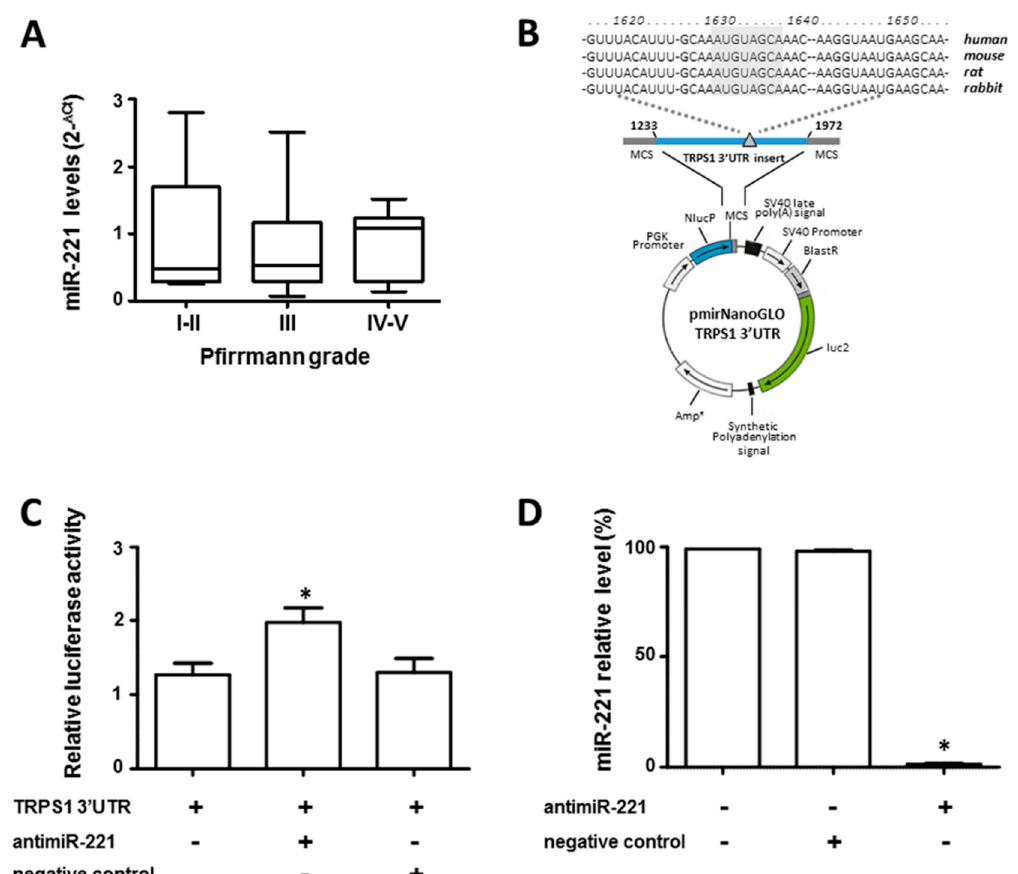
Figure 4. miR-221 directly targets TRPS1. The endogenous expression level of miR-221 was evaluated by qRT-PCR in the cells from IVD with a di ff erent Pfirrmann grade of degeneration ( A ). The relative miR-221 expression levels were reported by using 2 −(cid:52) Ct method (U6 snRNA was employed for normalization; all reactions were performed in triplicate, n = 30 (Pfirrmann I-II group, n = 8; Pfirrmann III group, n = 9 and Pfirrmann IV-V group, n = 13). Validation of miR-221 target site in the TRPS1 3 (cid:48) -UTR by reporter gene assay in IVD cells ( B ). Schematic representation of the luciferase construct utilized in this study is reported; partial sequences of the TRPS1 mRNA 3 (cid:48) -UTR harboring the predicted miRNA target site (gray triangle) was inserted in the indicated position. In the upper part of the panel the position of the predicted highly conserved miRNA target site is indicated. IVD cells were transfected for 48 h with a combination of reporter constructs (100 ng) along with antimiR-221 or negative control ( C ). Afterwards, the Nano Luc luciferase reporter gene ( NlucP ) and Firefly luciferase control reporter activities (luc2) were measured using a Nano-Glo Dual-Luciferase assay and represented as mean ± SD ( n = 6). The e ffi ciency of miR-221 silencing after antimiR-221 treatment is reported ( D ). The expression levels of miR-221 were measured by qRT-PCR. Data are presented as fold changes relative to untreated cells ± SD ( n = 6), * = p <